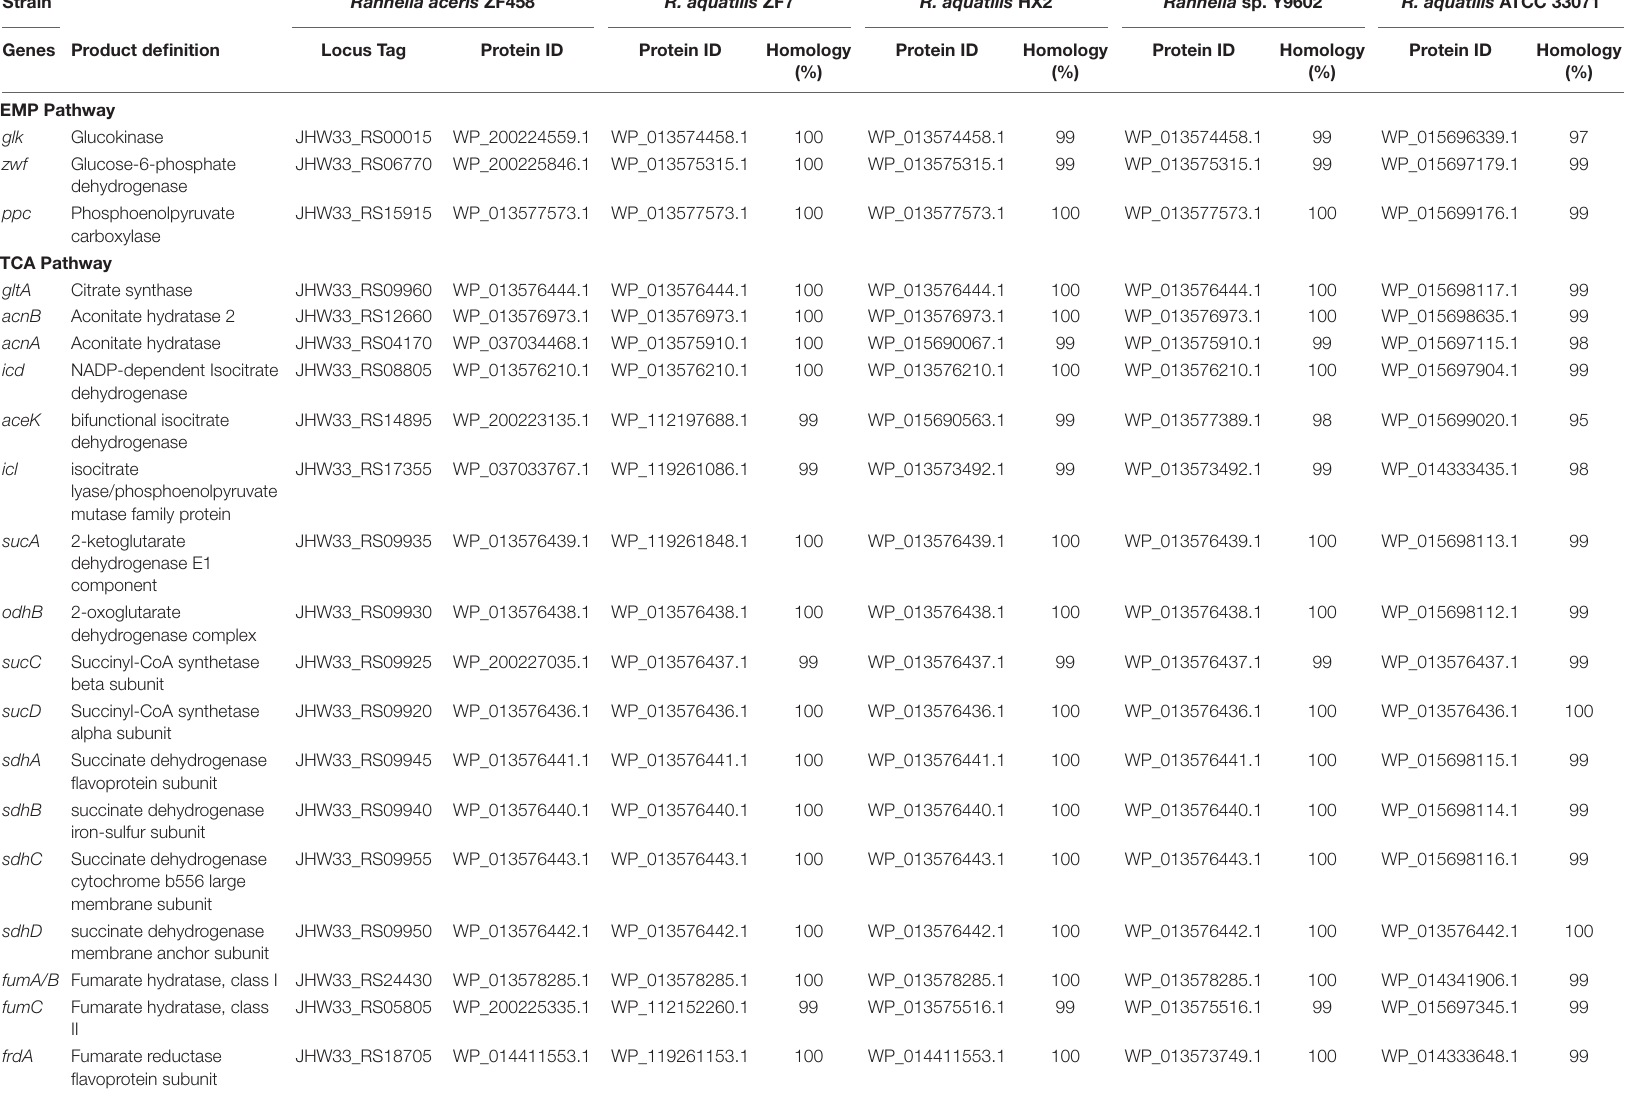
TABLE 4 | Homolog analysis of organic acid biosynthesis genes in R. aceris ZF458 and other Rahnella strains.